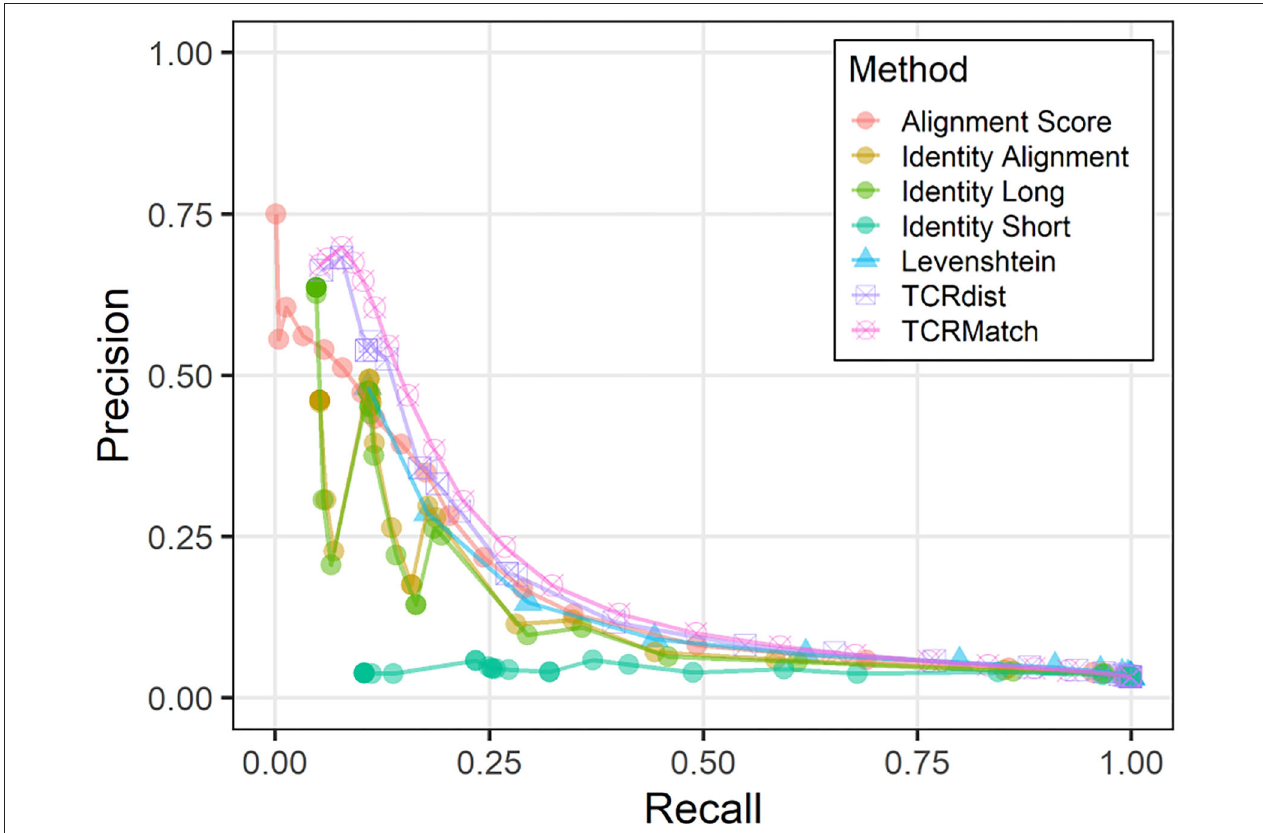
FIGURE 3 | Precision-recall plots comparing performance of sequence similarity metrics on 10x dataset. Precision and recall were calculated for all seven metrics across similarity thresholds in the analysis comparing the 10x dataset against